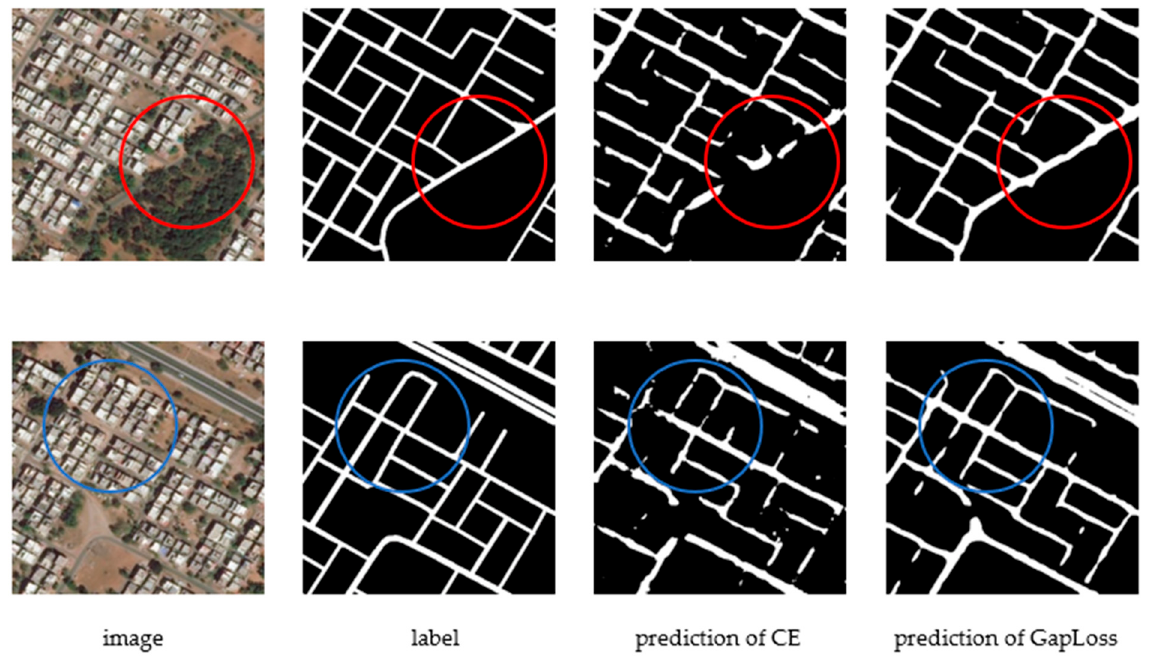
Figure 9. MUNet results with CE and GapLoss on DeepGlobe Roads Dataset. The blue and red circles indicate where the road continuity is improved after using GapLoss.